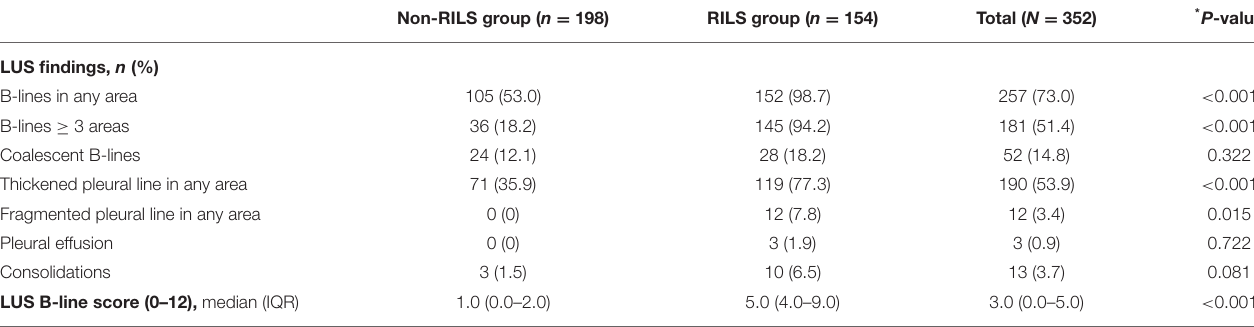
TABLE 5 | LUS findings at follow-up in relevant interstitial lung sequelae (RILS) groups categorized according to the Warrick score. Non-RILS group ( n = 198) LUS findings, n